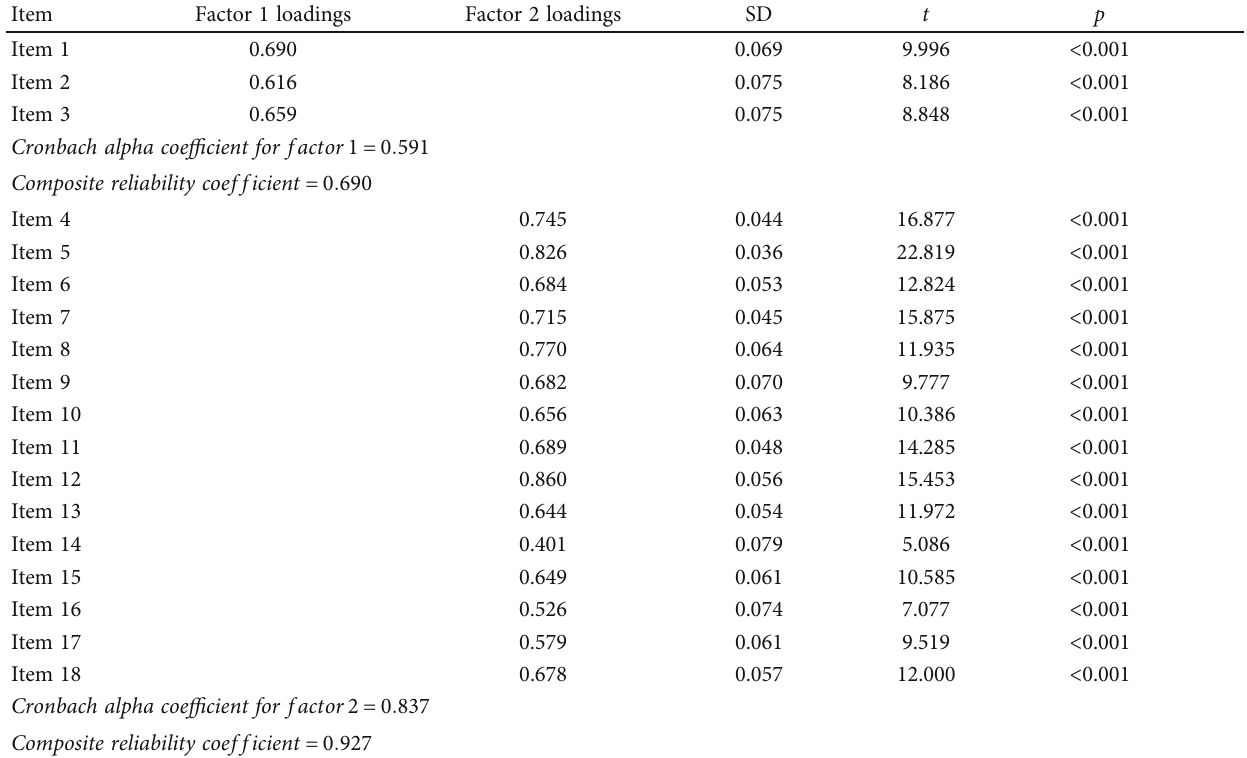
Table 5: Standard factor loads for the original two-factor unadjusted